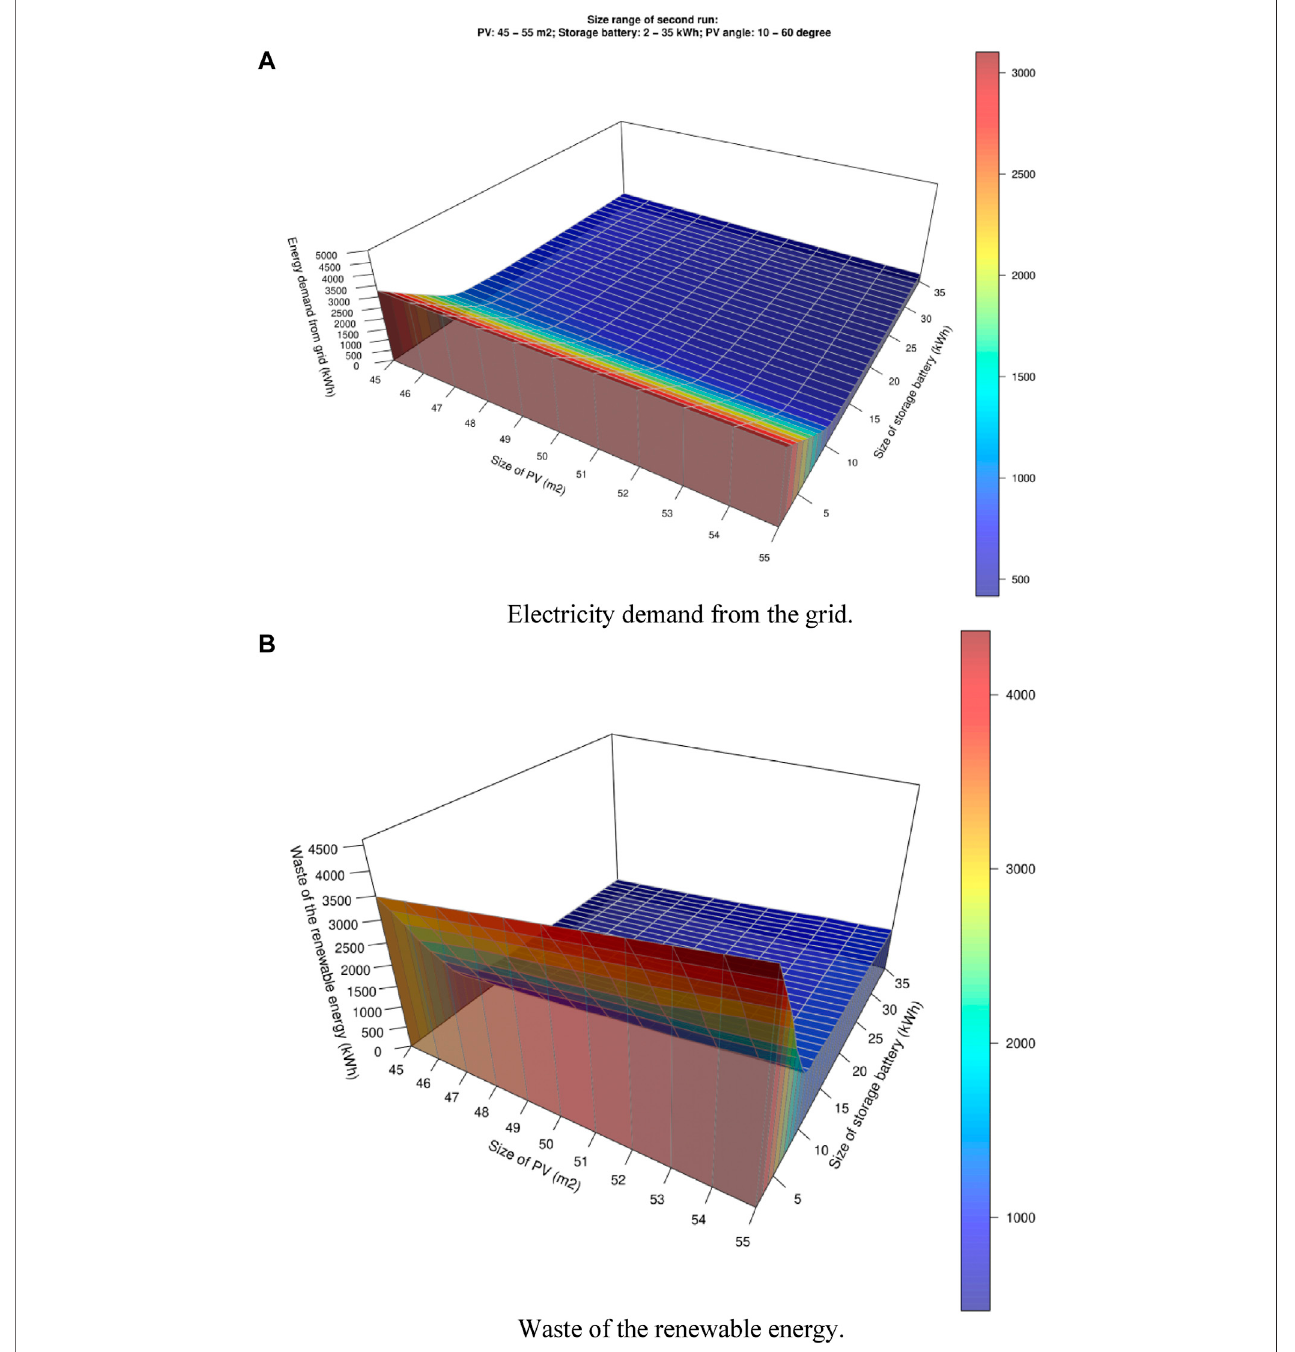
FIGURE 8 | Annual simulation results of the second run: (A) electricity demand from the grid; (B) waste of the renewable energy; (C) electricity usage from the PV; (D) electricity usage from storage battery.